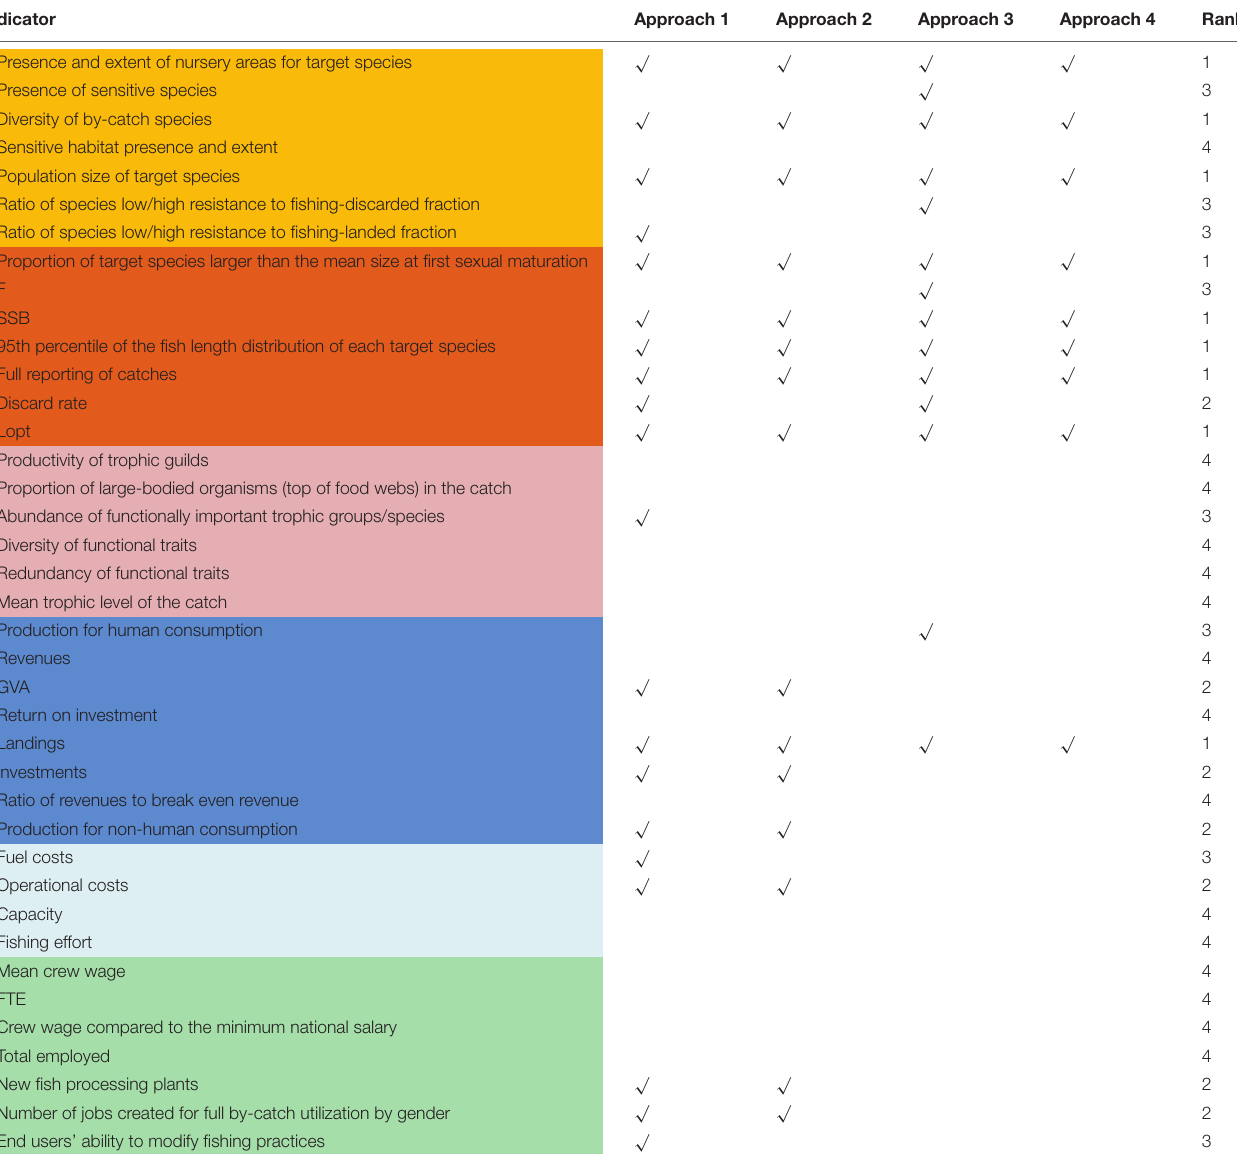
TABLE 2 | Ranking of the variables according to the frequency of selection by the four approaches: 1 = the indicator is selected by all approaches, 2 = the indicator is selected by two approaches, 3 = the indicator is selected by one approach, 4 = none of the approaches selected the indicator.